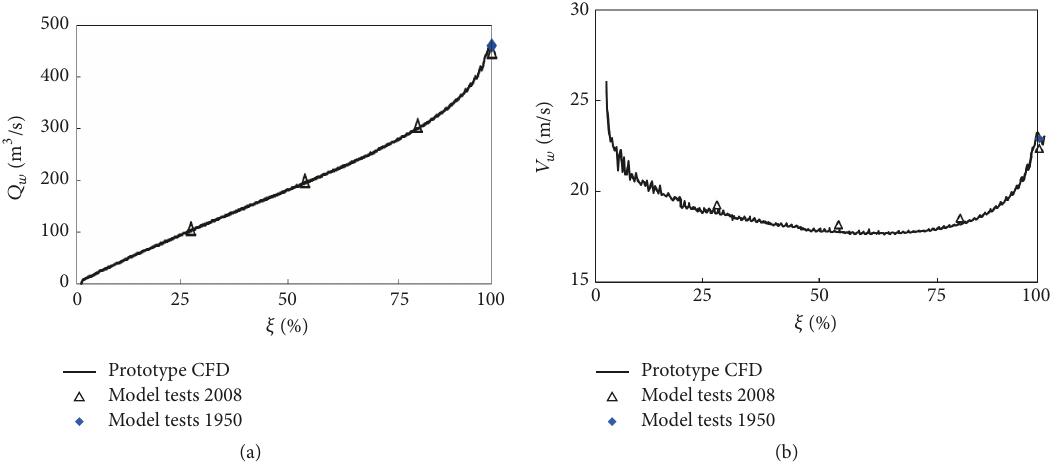
Figure 6: Comparisons between CFD and experiments, 𝑄 𝑤 and 𝑉 𝑤 as function of 𝜉 .